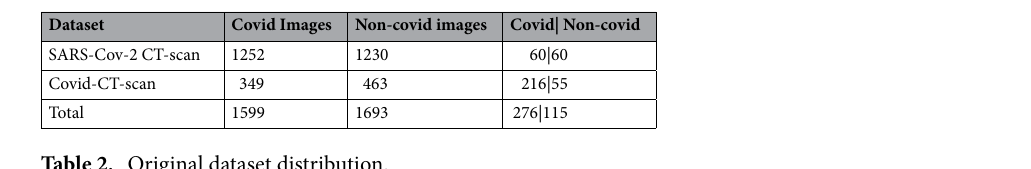
Table 2. Original dataset distribution.